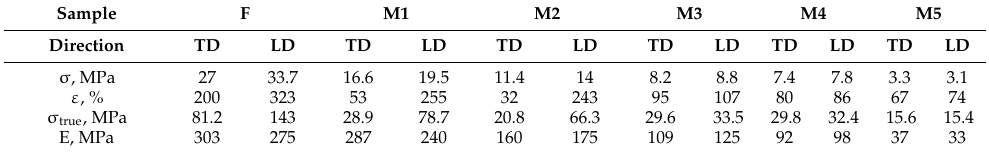
Table 3. Mechanical properties of the initial film (F) and resulting porous membranes (M1–M5).